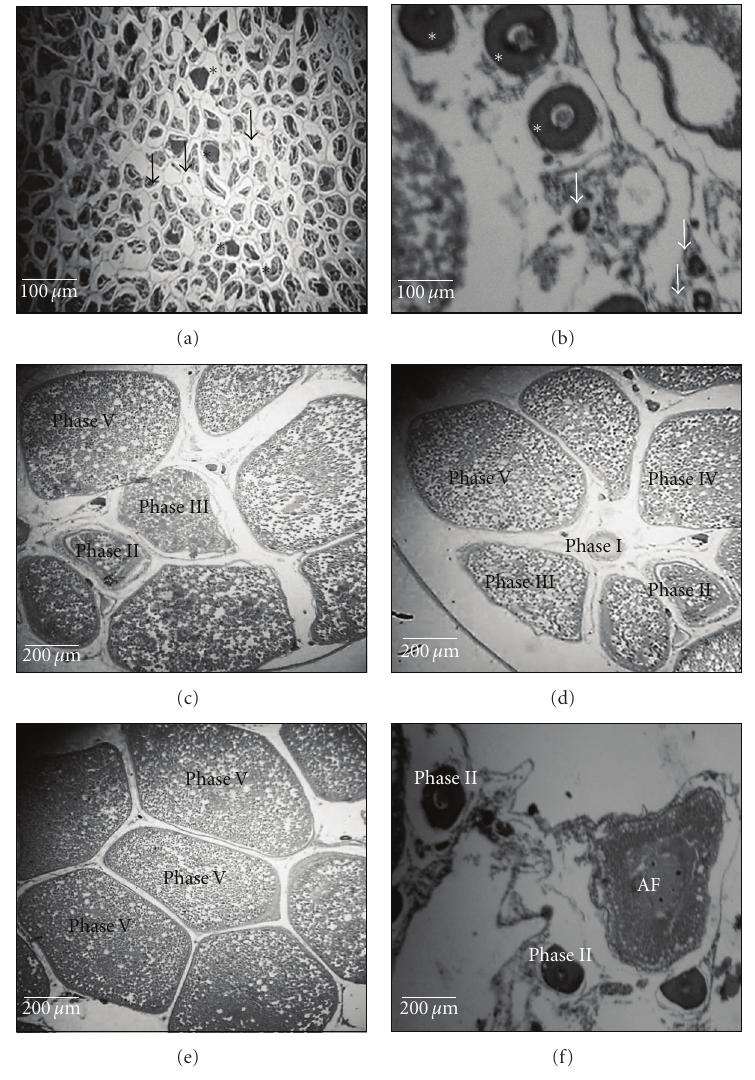
Figure 4: Histological aspects of oocytes developmental stages of C. menezesi : (a) and (b) immature ovary showing oocytes with chromatin nucleolus (Phase I) arrows; chromatin perinucleolus oocytes (Phase II) ∗ ; (c) maturing ovary with reserve stock perinucleolus oocytes (Phase II), lipid vitellogenic stage oocytes (Phase III), lipid and protein vitellogenic stage oocytes (Phase IV); (d) and (e) mature ovary showing several batches of oocytes at di ff erent stages of development (Phase I to V); (f) partially spent stage showing oocytes phase III and atretic follicles